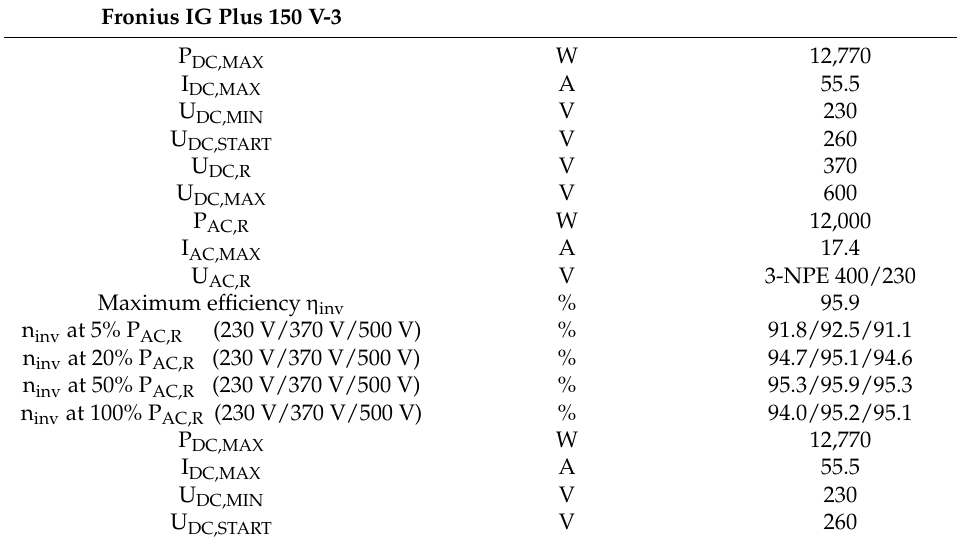
Table A2. Technical characteristics and efficiency ratings of inverters.